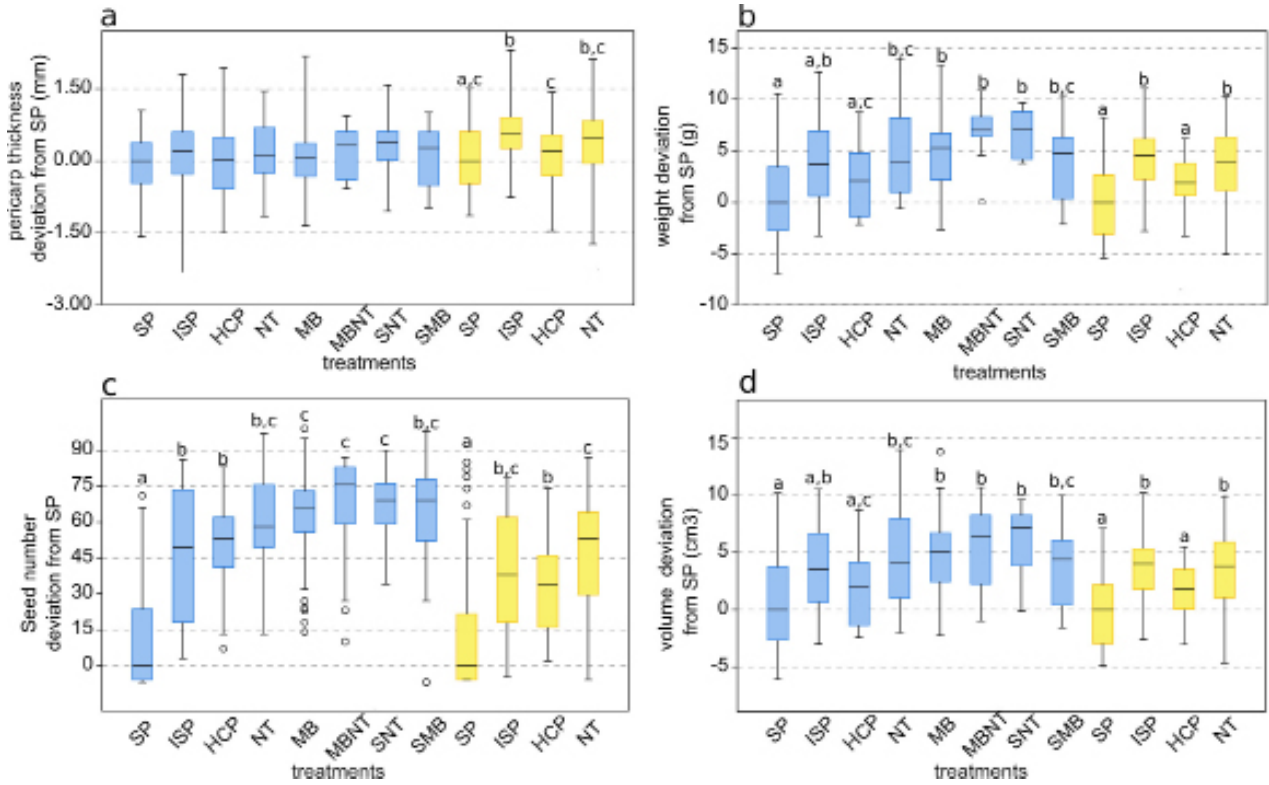
Fig 2 . Box-plot and statistic differences among four parameters of cherry tomatoes measured in the present study in greenhouses A (blue) and B (yellow). (a) Pericarp thickness; (b) Weight; (c) number of seeds; (d) volume derived from transverse and longitudinal diameters. Boxplot bars depicts quartile intervals, inner line the median position, out lines the boundaries of the distribution and circle the outliers. Letters over the box-plots indicate the statistical differences ( p < 0.05) according to the Kruskal-Wallis and Dunn’s post hoc tests. Boxplot bars depicts quartile intervals, Spontaneous self-pollination (SP); induced self-pollination (ISP); hand cross pollination (HCP); pollination by M. bicolor and N. testaceicornis (MBNT); pollination by M. bicolor (MB); pollination by N. testaceicornis (NT); pollination by bees (BP); single visit